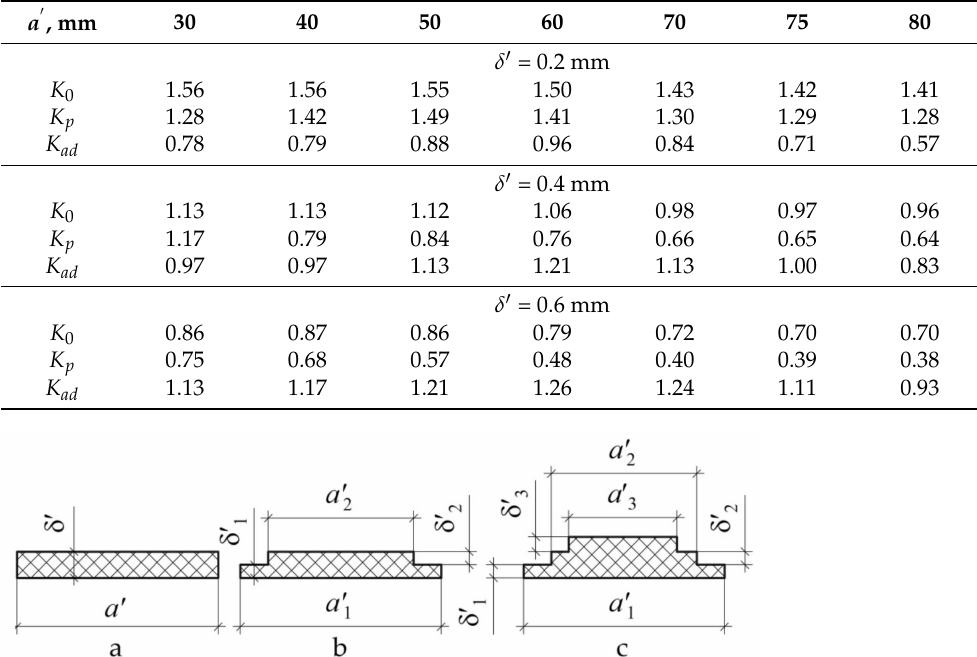
Figure 10. Geometrical dimensions of the cross section of repair patch of uniform thickness ( a ) and variable thickness with two ( b ) and three ( c ) steps. Table 2. Results of calculation of the loading factors with the use of the repair patch of the variable thickness with two steps (Figure 10b) at δ (cid:48)